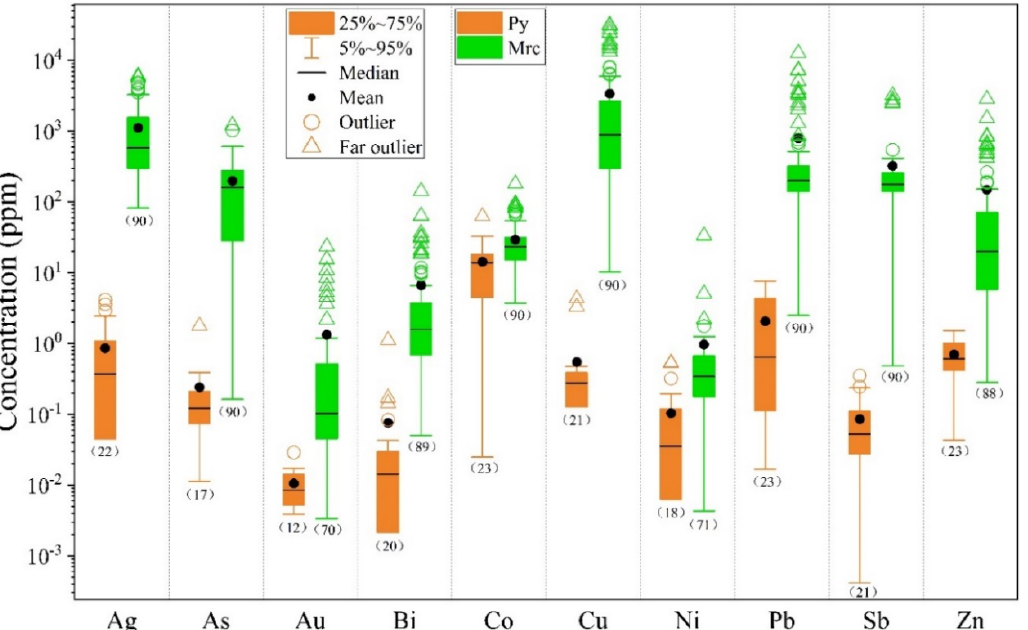
Figure 7. Box plots of selected trace elements in pyrite and marcasite. The number of reliable spots is given in parenthesis.